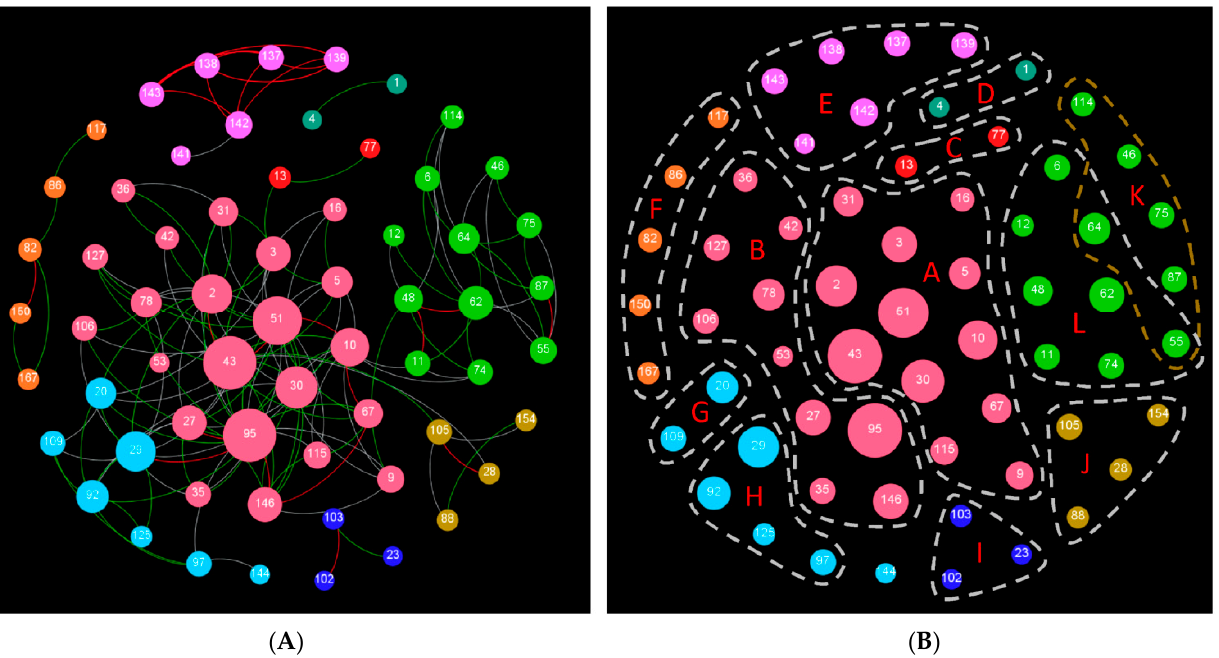
Figure 2. ( A ) Co-occurrence network for the GHFs as constructed by Gephi and ( B ) the classified functional categories. Solid circles (nodes) represent various GHFs, which are divided into nine modules, distinguished with colors. Red lines (edges) suggest strong correlations (Spearman’s ρ > 0.6), and green as well as grey lines infer moderate-strong correlations (0.5 < ρ < 0.6 as well as 0.45 < ρ < 0.5, respectively). An array of functional categories are clustered and marked with dash